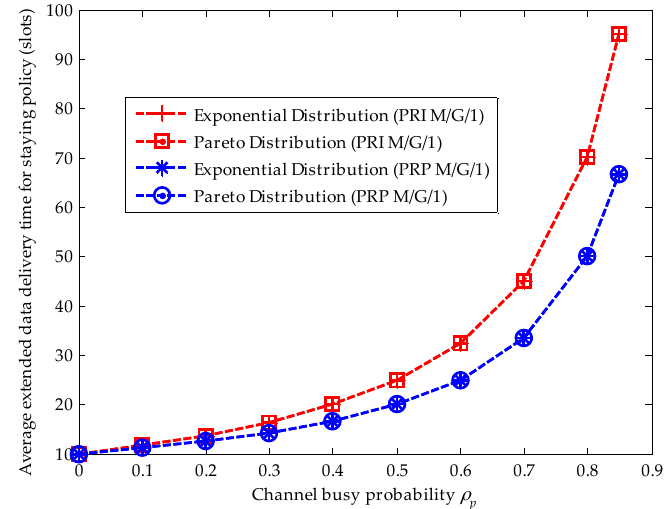
Figure 4. Effects of the upper-truncated Pareto distribution and the exponential distribution for primary connections when the staying policy is adopted in the preemptive repeat identical (PRI) M/G/1 and the preemptive resume priority (PRP) M/G/1 queuing network models.